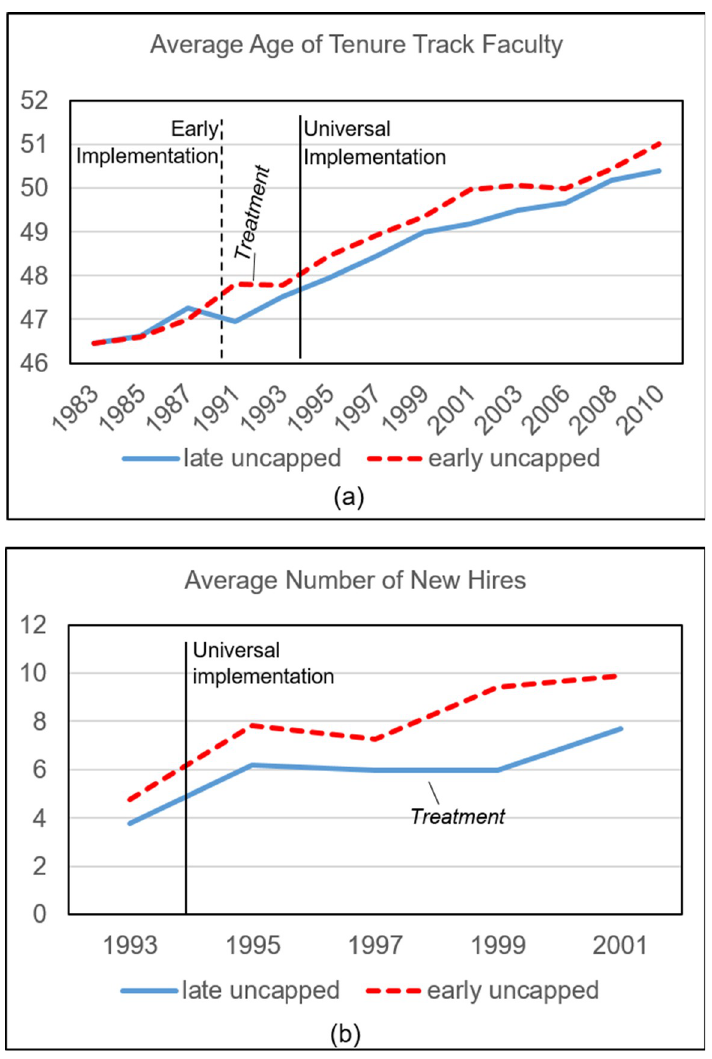
Fig 4. (a) The trend of average age of tenure-track faculty from 1983 to 2010 by type of institution (whether they eliminated mandatory retirement early or late); (b) the trend of the average number of new hires for each institution from 1993 to 2001 by type of institution. Note: Black solid line (universal implementation) indicates the time of elimination of mandatory retirement on the federal level for all schools, black dashed line (early implementation) indicates the elimination of mandatory retirement on the state level for early uncapped